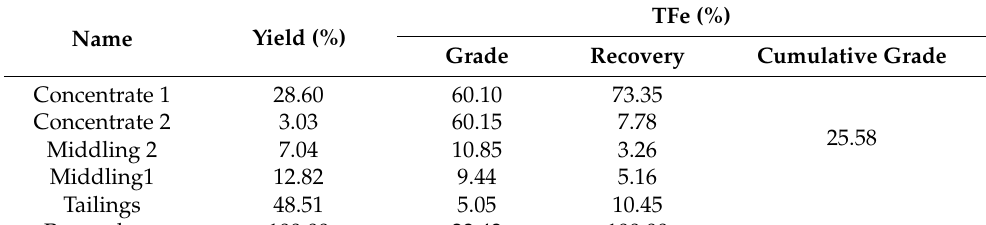
Table 4. The results of the flash suspension roasting-magnetic separation.